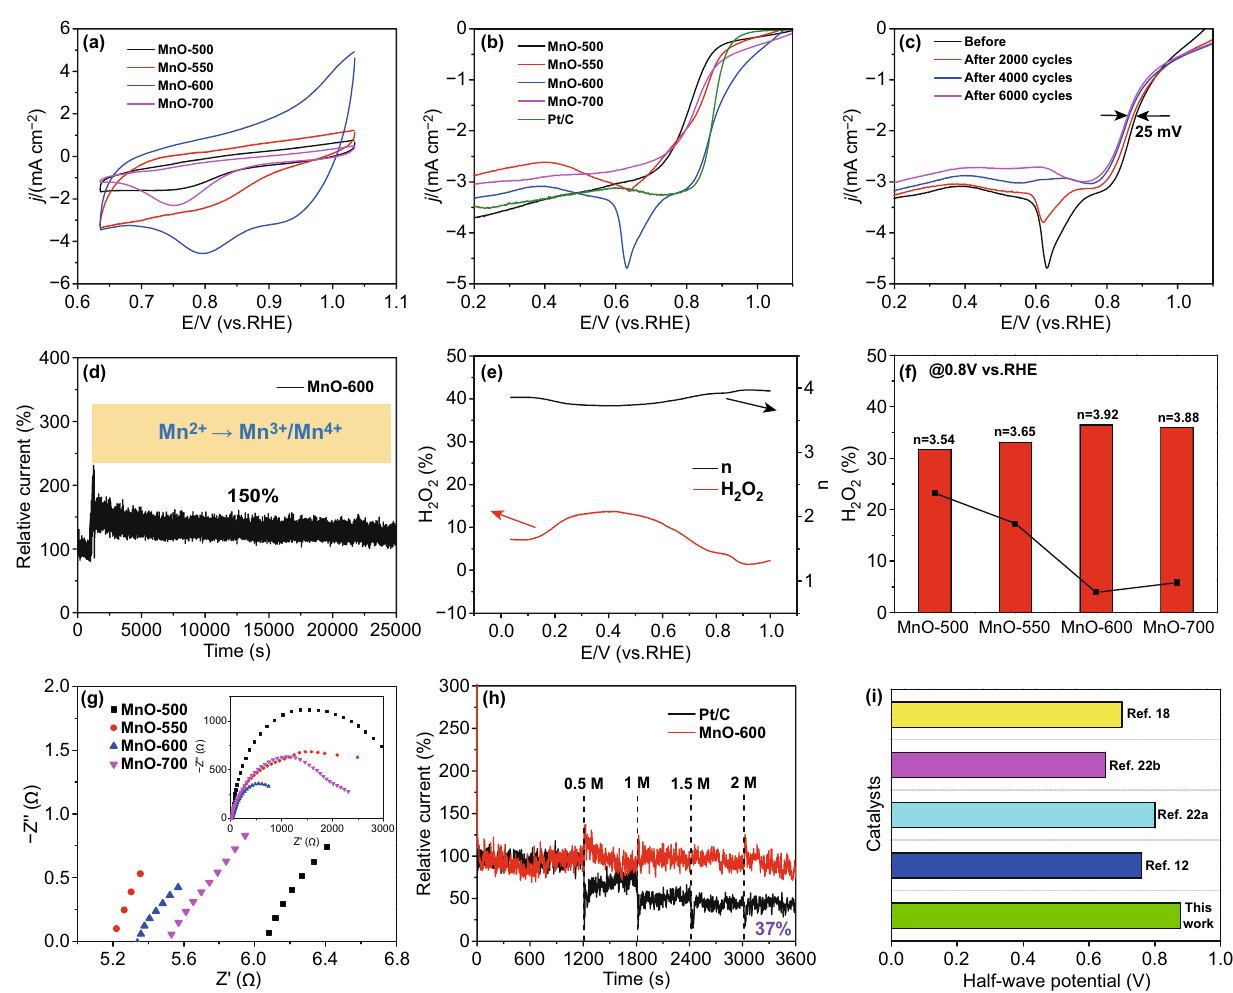
Fig. 4 ORR performances of the prepared catalysts and their comparisons in 1 M KOH solution. a CV curves of MnO-T catalysts. b LSV curves of MnO-T catalysts at a scan rate of 10 mV/s. c Stability measurements for MnO-600 sample at the initial cycle and after 2000, 4000 and 6000 cycles. d Time-dependent current density curve at 0.7 V (vs. RHE) obtained by continuous test for 25,000 s. e H 2 O 2 yields of MnO-600 at varied potentials and the corresponding electron transfer numbers. f H 2 O 2 yields (dots) and the corresponding electron transfer numbers (col- umns) at 0.8 V (vs. RHE) for different catalysts. g Nyquist plots of the catalysts (inset: AC impedance curves of different catalysts at the poten- tial of 0.965 V (vs. RHE) and in the frequency range from 10 −2 to 10 5 Hz). h Tolerance measurements to methanol at 0.7 V (vs. RHE) for Pt/C and MnO-600 catalysts. i Comparison of ORR performances among MnO x -based electrocatalysts in the alkaline